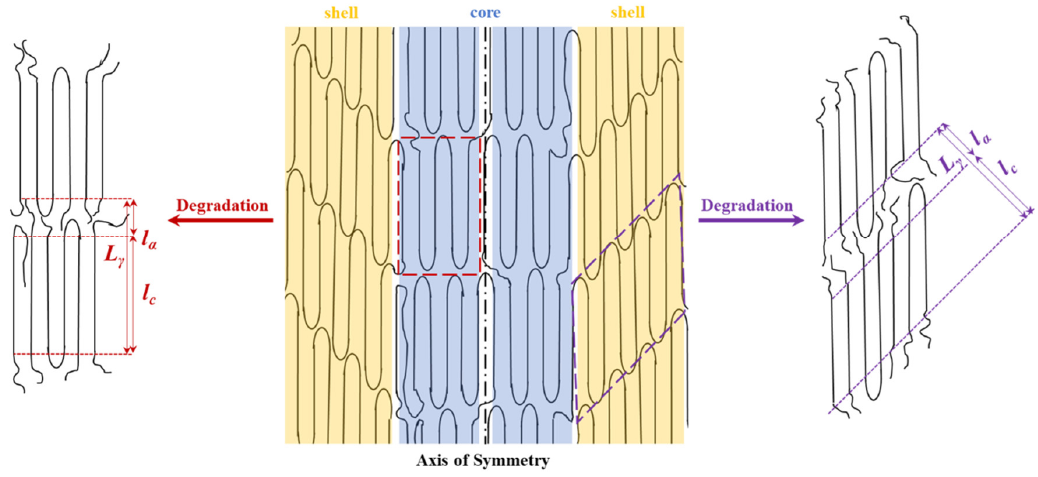
Figure 9. Scheme showing the structure of annealed fibers characterized by the presence of two types of lamellar crystals that are part of the shell and the core before and after being submitted to hydrolytic degradation.